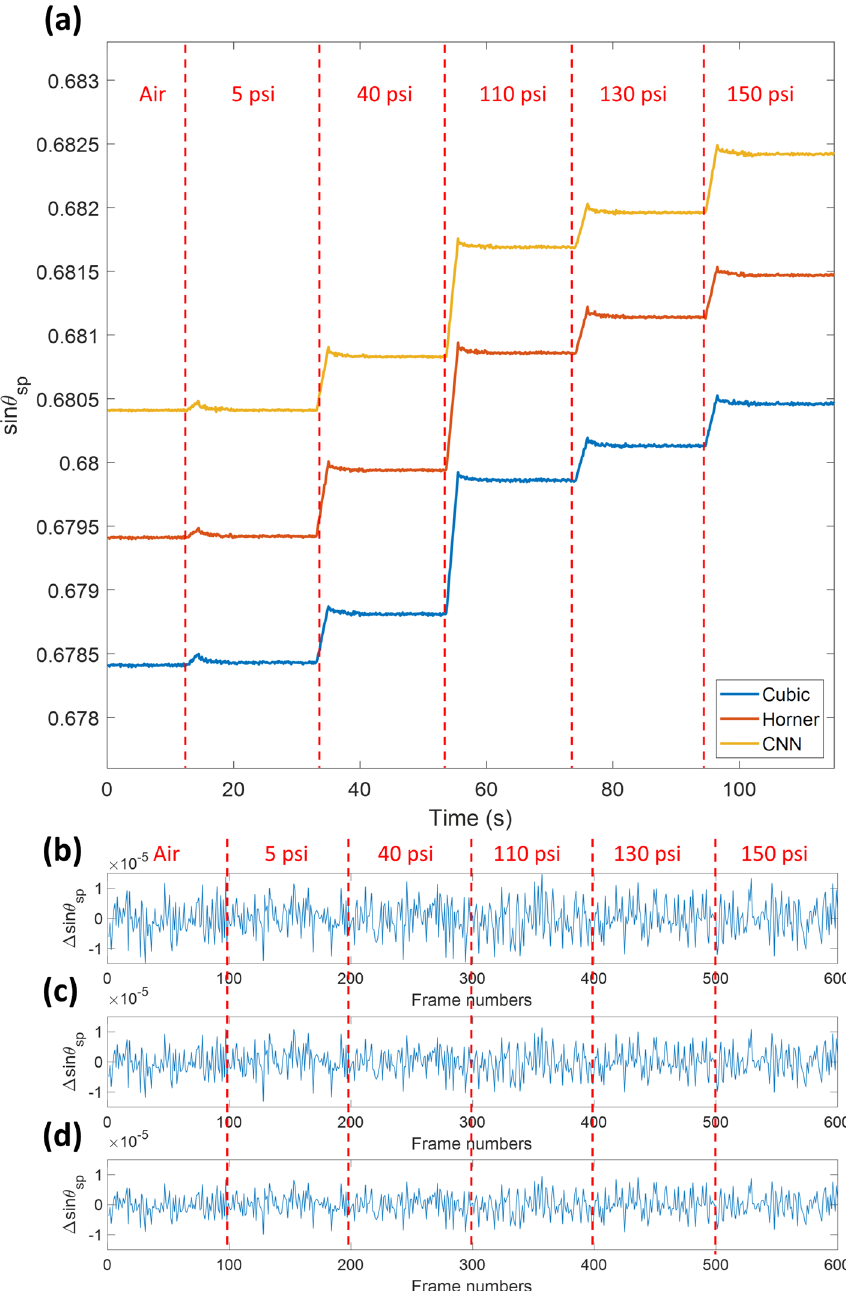
Figure 12. ( a ) Sensorgram of three methods for the five N 2 pressure levels with 0.005 offset for each sensorgram, ( b ) Δsinθ sp noise levels in the cubic polynomial method, ( c ) Δsinθ sp noise levels in Horner’s method, and ( d ) Δsinθ sp noise levels in the CNN